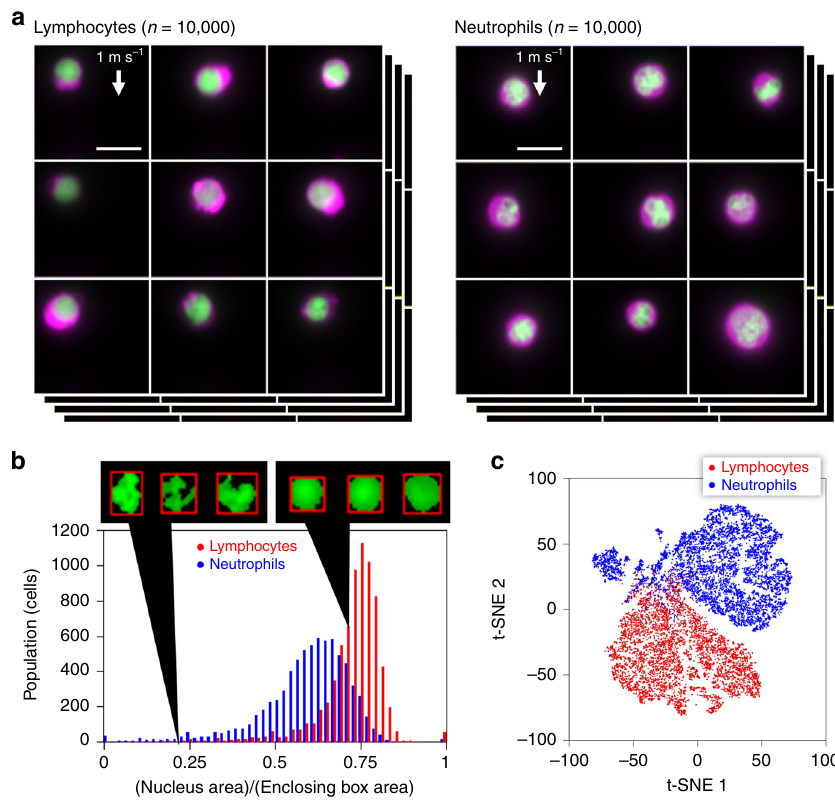
Fig. 4 High-throughput, high-content screening of murine neutrophils, and lymphocytes with VIFFI fl ow cytometry. a Libraries of fl uorescence images of the cells ( n = 10,000 for each group) obtained by VIFFI fl ow cytometry. The cytoplasm was stained by CellTracker Red (shown in magenta) while the nucleus was stained by SYTO16 (shown in green). Different color scales are used for the fl uorescence images of murine neutrophils and lymphocytes for higher image contrast. See Supplementary Figs. 19 and 20 for more images. b Histogram of the cells in the ratio in area between the nucleus and enclosing box ( n = 7399 for lymphocytes and n = 7398 for neutrophils). The source data is available in our Source Data fi le. c t-SNE plot of the cells obtained with 4096 features by VGG-16 ( n = 8000 for each group). A sub-type of neutrophils is evident at around (t-SNE 1, t-SNE 2) = ( − 70, 40). The source data is available in our Source Data fi le. Scale bars: 10 µ (Fig. 3c), the boundary (cell surface) localization of the epithelial cell adhesion molecule (EpCAM) in CTCs (Fig. 3d), nuclear lobulation in murine neutrophils (Fig. 3e), and lipid droplet localization in E. gracilis cells (Fig. 3f) that have not been possible with previous high-throughput imaging fl ow cytometers at this fl ow speed 20,26 due to their limited imaging sensitivity. Below we used murine white blood cells and E. gracilis cells to show practical applications of VIFFI fl ow cytometry.